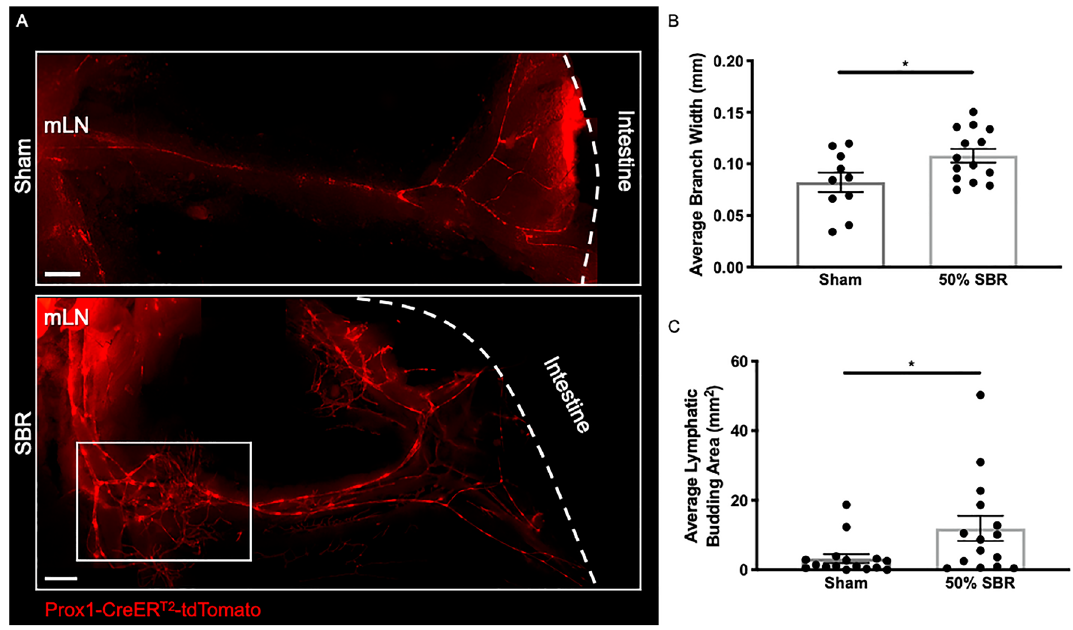
Figure 6. Effect of SBR on mesenteric lymphatic vessels at post-operative week 13. ( A ) Whole mount fluorescence stereoscope image of collecting lymphatic vessels (Prox1-tdTomato +) (red) in sham and 50% SBR mice in regions in the ileum-draining mesentery distal to the anastomosis. Example of budding area is outlined by white box; mesenteric lymph node (mLN) is designated to the left and intestine to the right (white dashed line). Scale bar 1000 μm. ( B ) Average width of lymphatic branches and ( C ) average lymphatic budding area draining the bowel distal to the anastomosis in sham ( n = 10 branches in 4 mice) and 50% SBR ( n = 14 branches in 4 mice). * p <